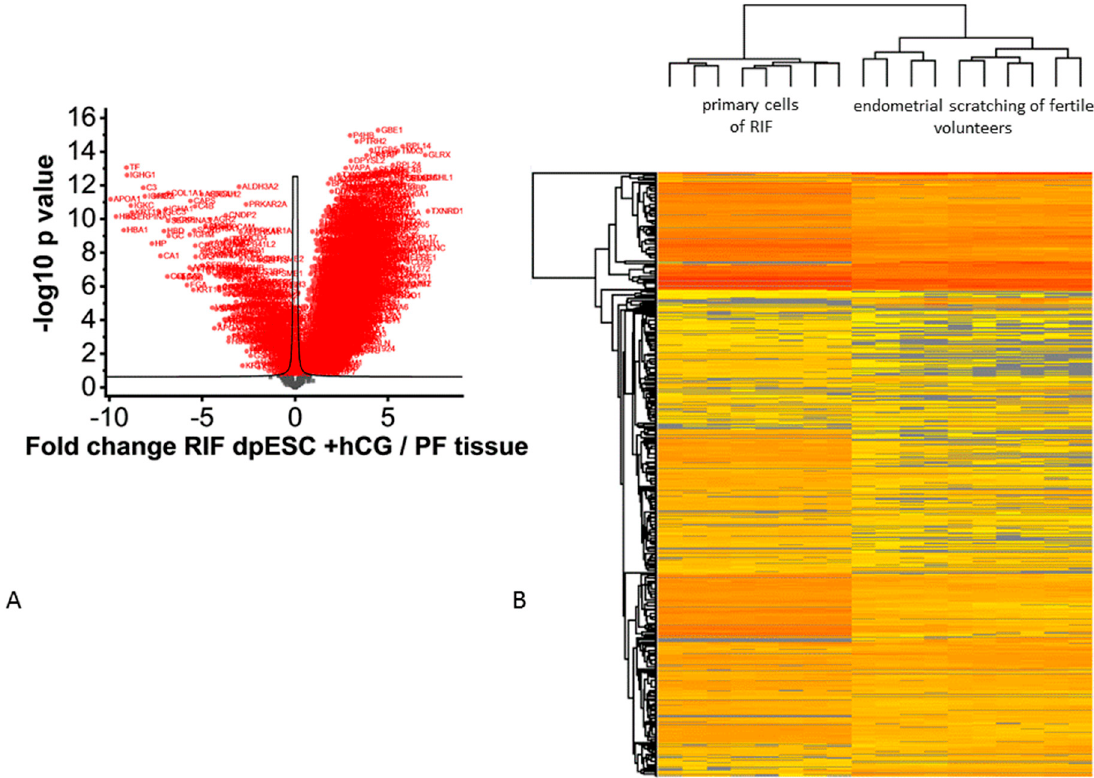
Figure 4. Volcano plot analysis of RIF dpESCs incubated with 100 IU/mL hCG vs. the endometrial tissue of PF ( A ). All proteins displayed in red show a statistically significant altered abundance. ( A ) heatmap (low to high abundance is coded by yellow to red color) representing the unsupervised hierarchical cluster analysis is shown in ( B ).